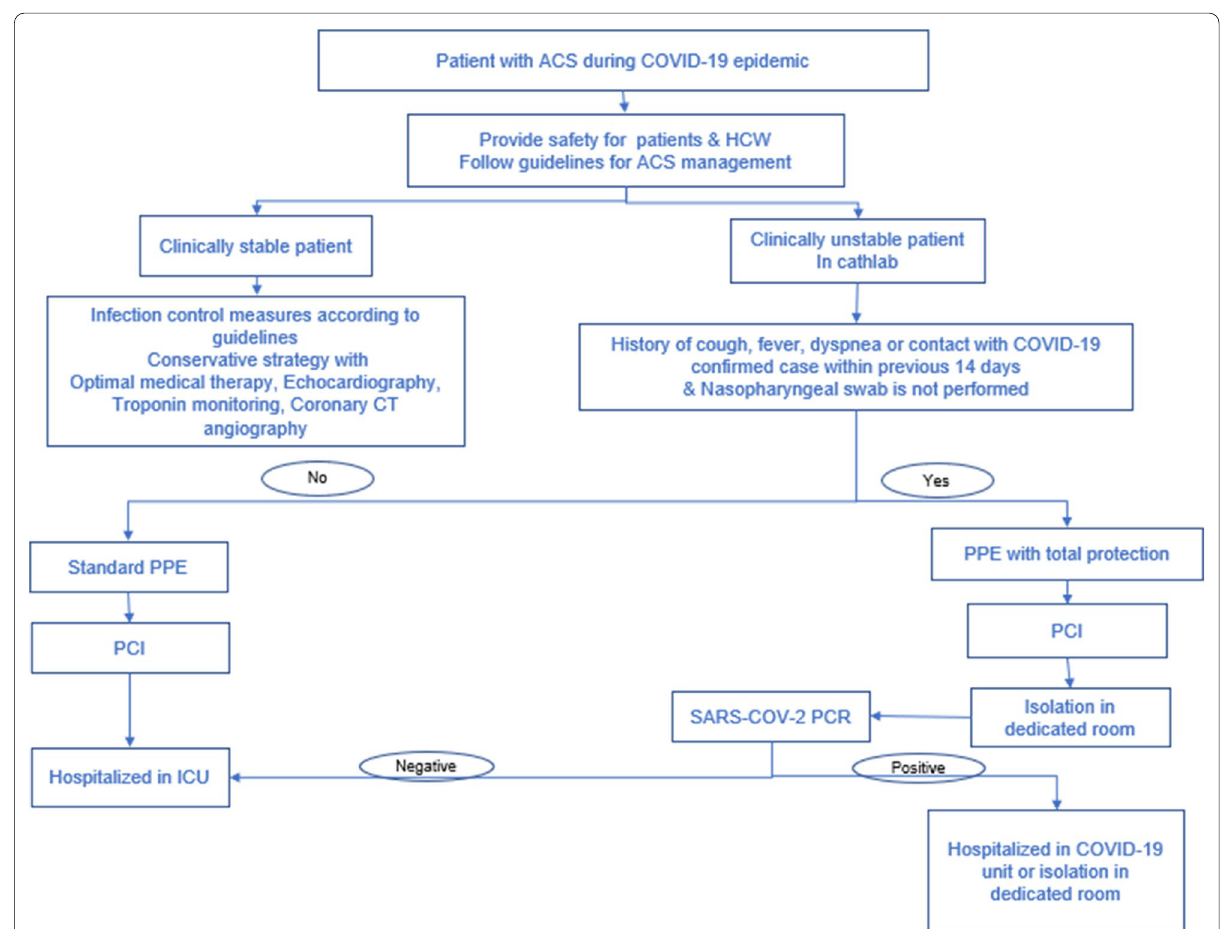
Fig. 4 Algorythm for management of acute coronay syndrome during COVID-19 epidemic. ACS: acute coronay Syndrome, ICU: intensive care unit, PPE: personal protective equipment, HCW: healthcare